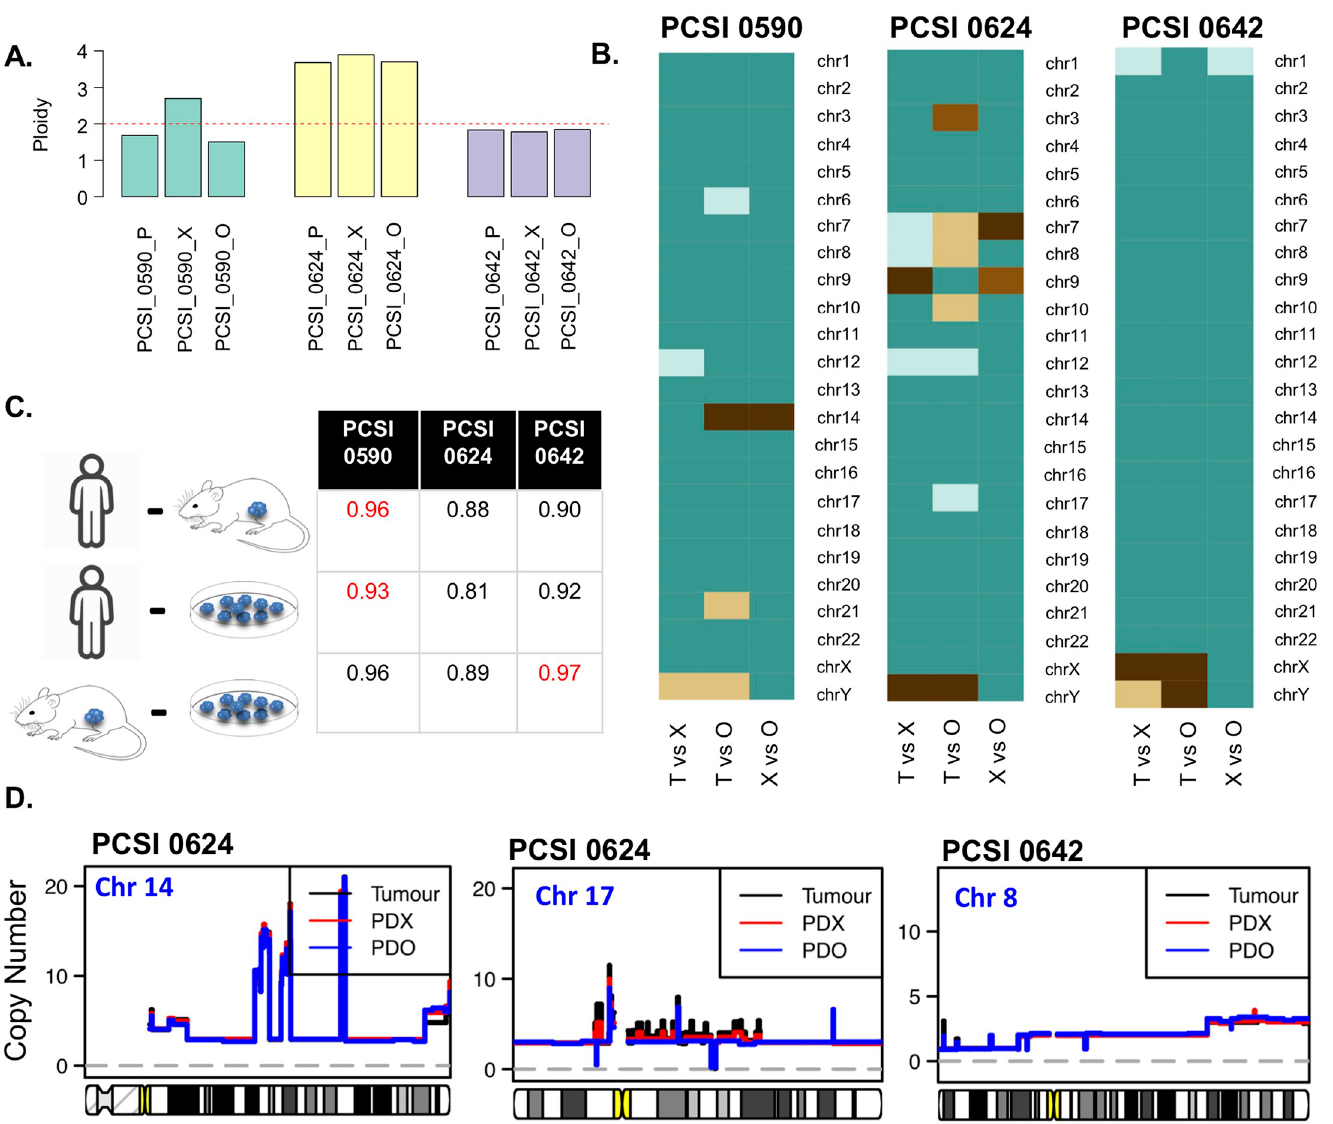
Fig 8. Comparative analysis of copy number state across tumour-PDX-PDO trios of the resected primary cohort. (A) Ploidy across primary-PDX-PDO trios. (B) Chromosome-specific Jaccard indices across 3 primary-PDX-PDO trios (PCSI_0590, PCSI_0624, and PCSI_0642). Each trio is split into 3 pairs representing primary- PDX (T vs X), primary-PDO (T vs O) and PDX-PDO (X vs O) comparisons. (C) Genome-wide concordance score for primary-PDX, primary-PDO, and PDX-PDO pairs for 3 trios. The highest scoring sample for across tumour-PDX, tumour-PDO, and PDX-PDO pairs is highlighted in red. (D) Copy number state (uncorrected) of primary tumour (black), matching PDX (red), and matching PDO (blue), highlighted for chromosomes for which chromothripsis had been observed.